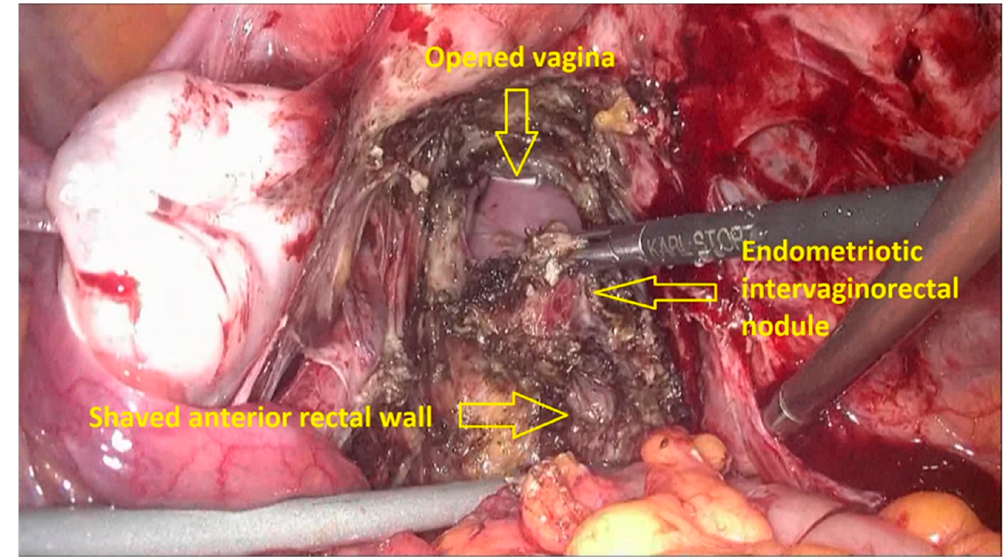
Figure 6. Excision of a vaginal patch, followed by vaginal closure .